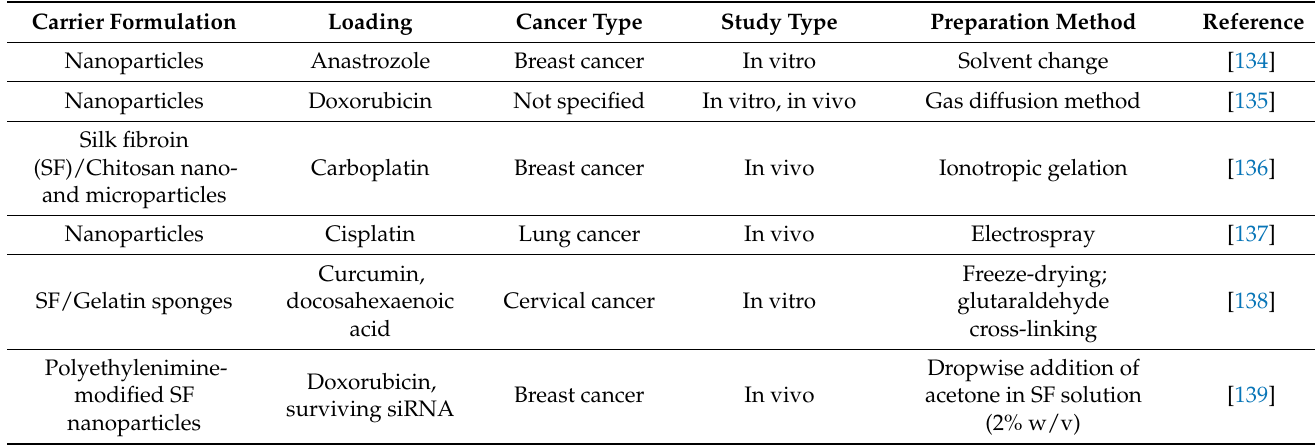
Table 3. Fibroin-based carriers for various cancer